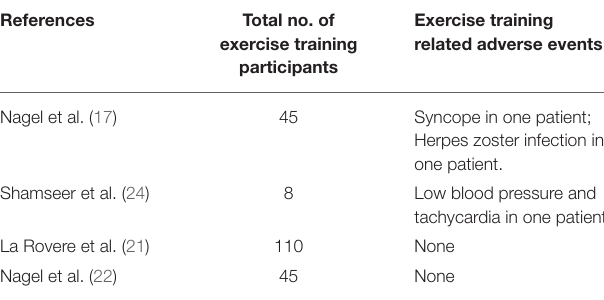
TABLE 5 | Adverse effects reported in the included studies.